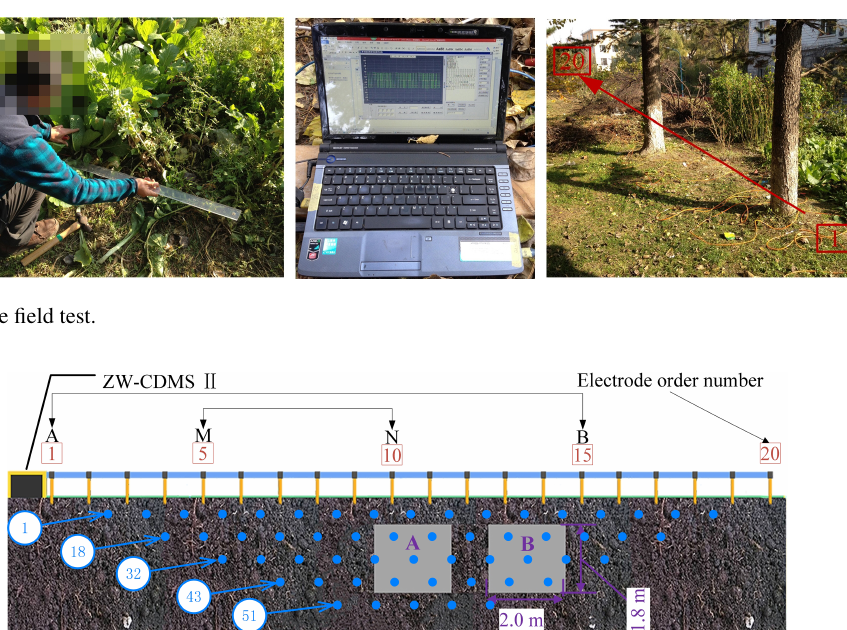
Figure 11. The schematic of the two high-resistance